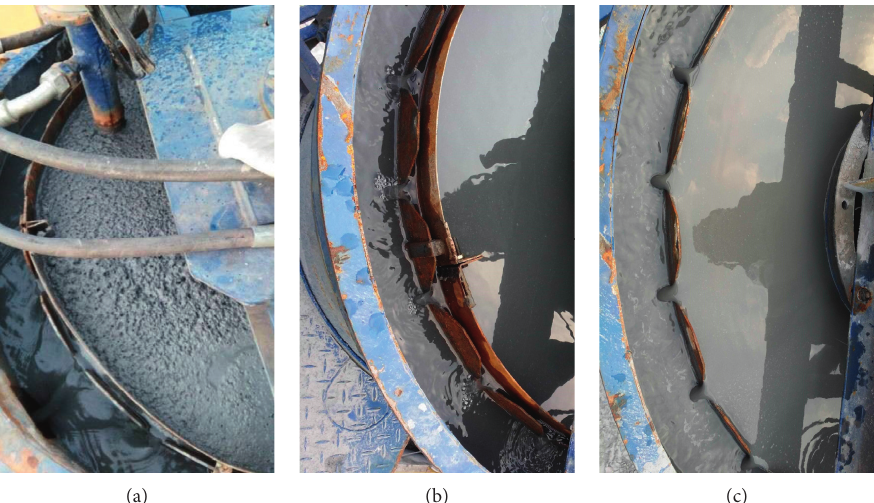
Figure 11: FS effect of different combinations on the liquid surface in the small deep-cone thickener after operating for 10 hours: (a) L&A group, (b) S&A group, and (c) C&A group.